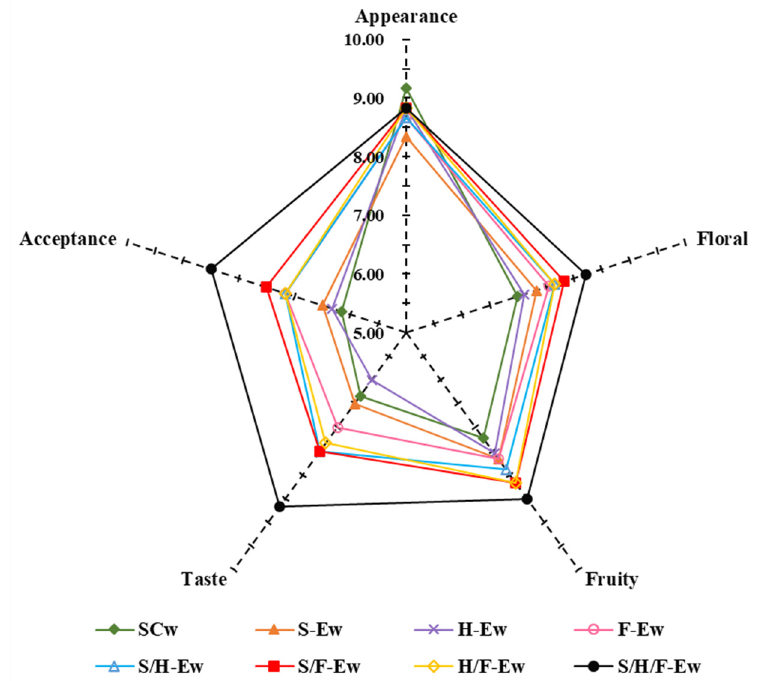
Figure 5. Sensory evaluation of